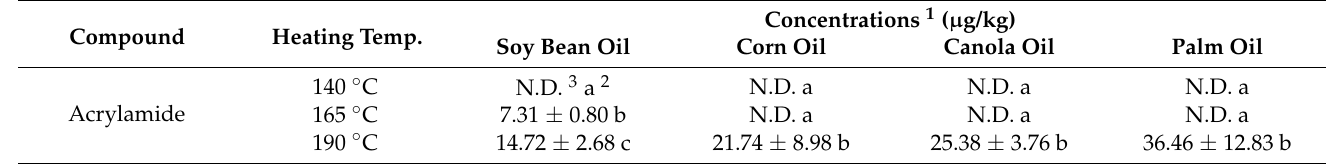
Table 2. The formation of acrylamide in WOF (Welsh onion fried) samples at 190 ◦ C. Compound Heating Temp. Soy Bean